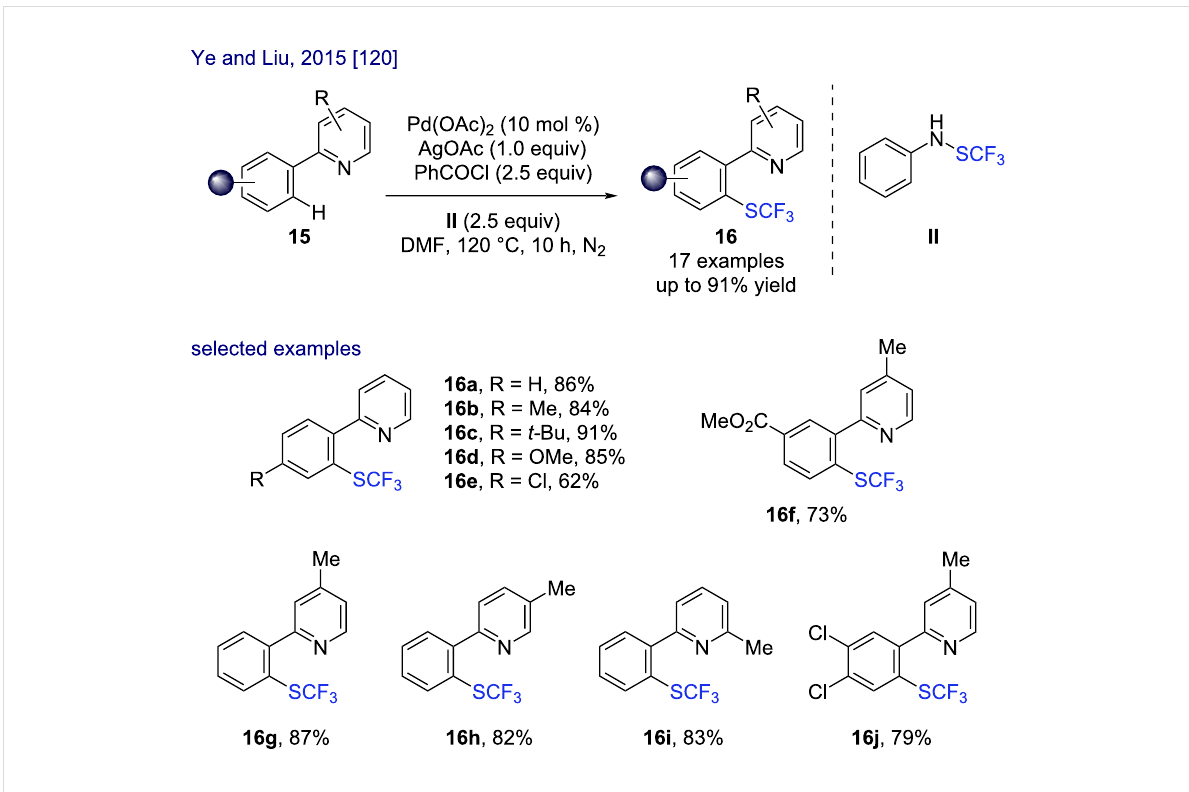
Scheme 7: Palladium-catalyzed ortho -trifluoromethylthiolation of 2-arylpyridine derivatives reported by the group of Ye and Liu